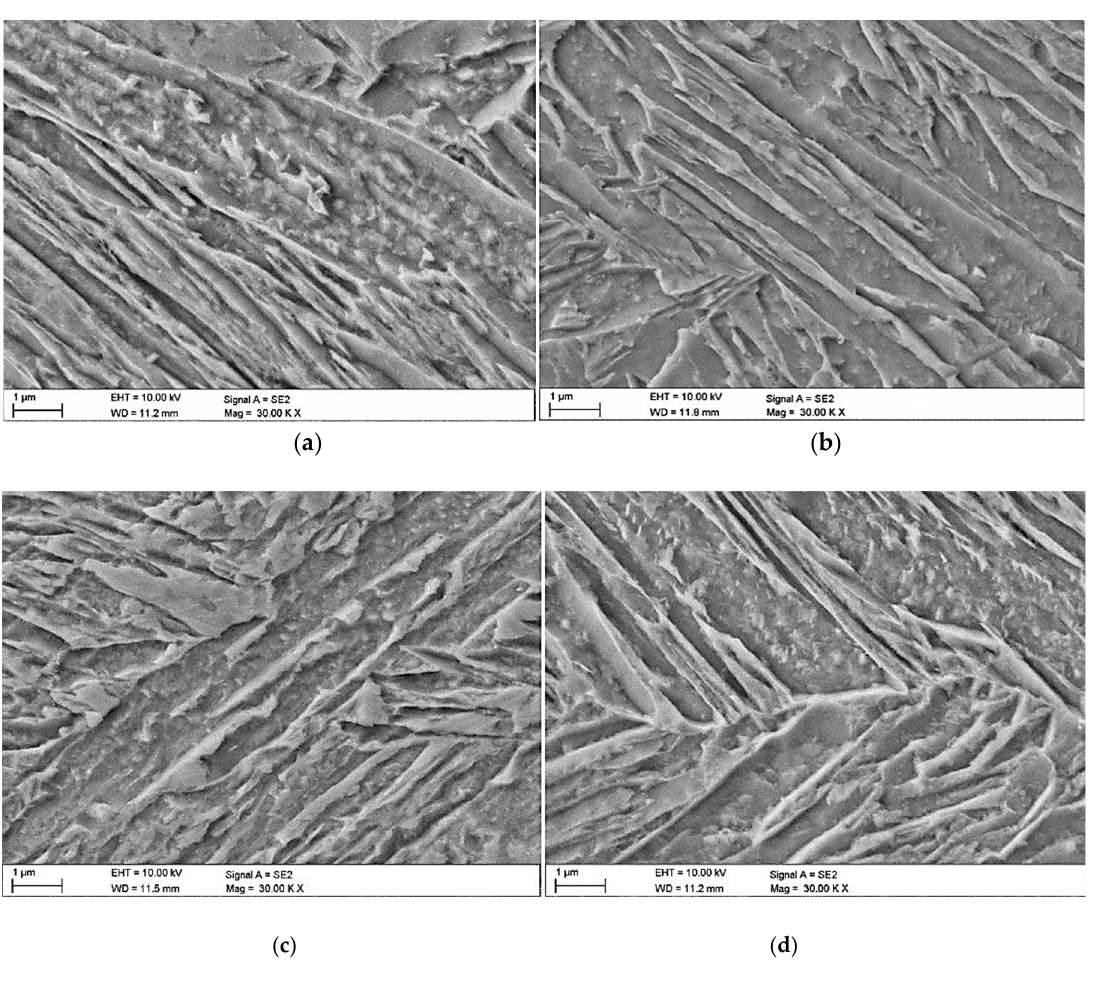
Figure 6. SEM micrographs of the 5Mn steel deformed at: (a) 20 °C, (b) 60 °C, (c) 100 °C, and (d) 140 °C.